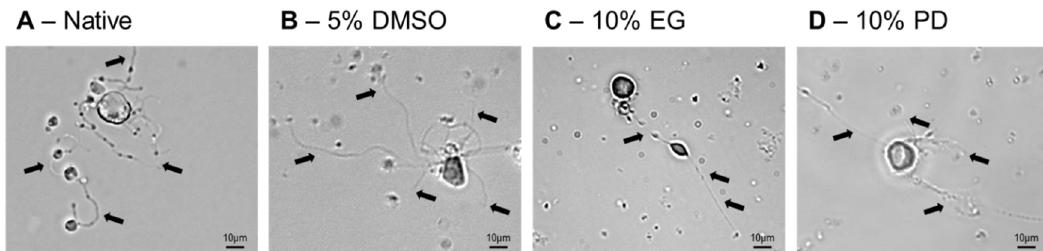
Figure 6. Functional capability of in vitro iPSC-derived MKs to form proPLTs before ( A ) and after (( B )—5% DMSO; ( C )—10% EG; ( D )—10% PD) cryopreservation. ProPLTs indicated with arrows.